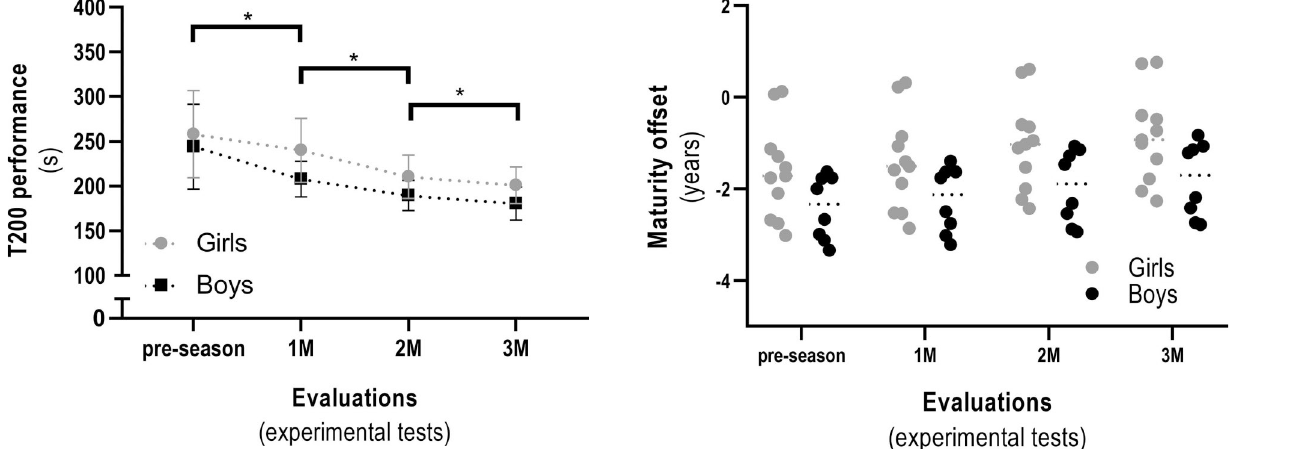
Figure 3 - Maturity offset for girls and boys at baseline (pre-season) and each macrocycle.